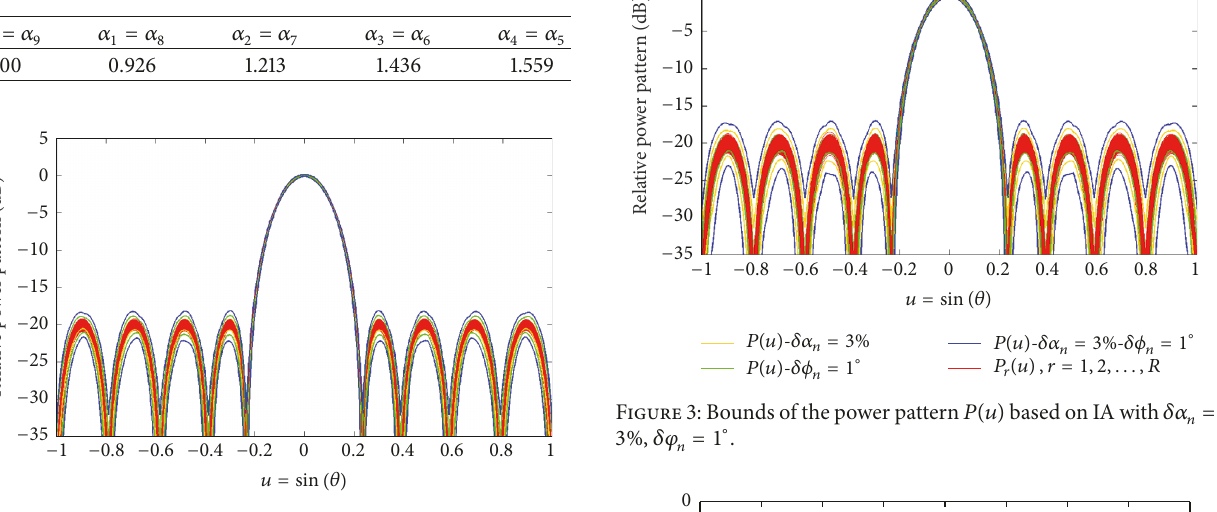
Table 1: Amplitude distribution ( 𝑁 = 10 , 𝑑 = 𝜆/2 ; Chebyshev: SLL ref = −20 dB).